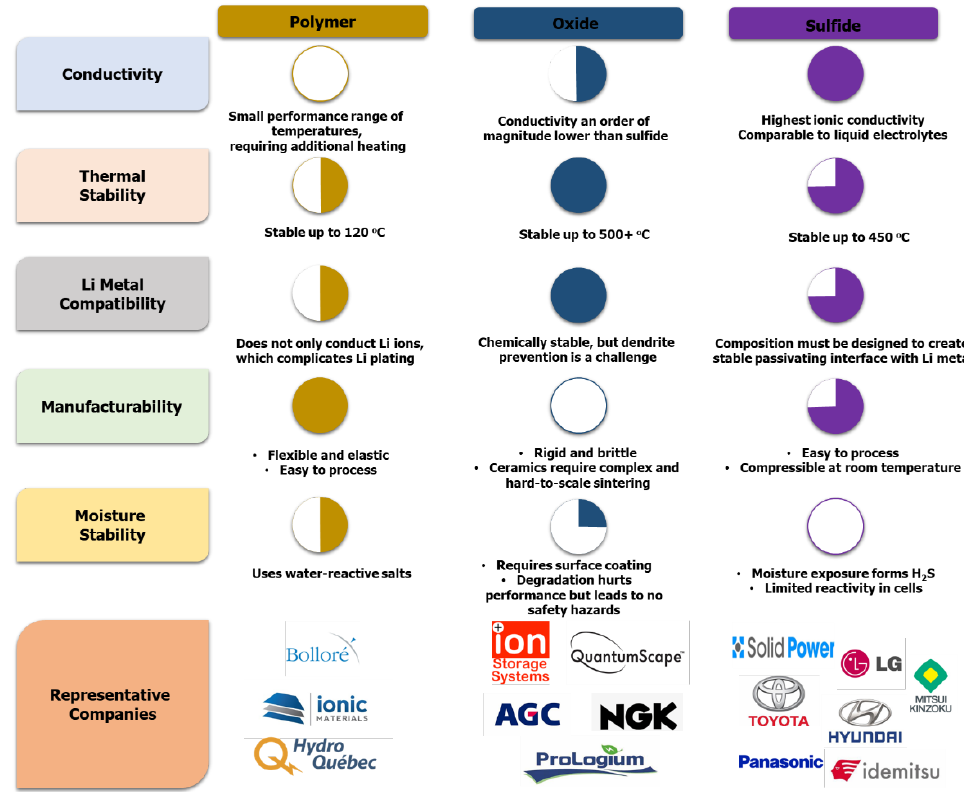
Figure 8. An overview of key material properties for the design of SSBs.